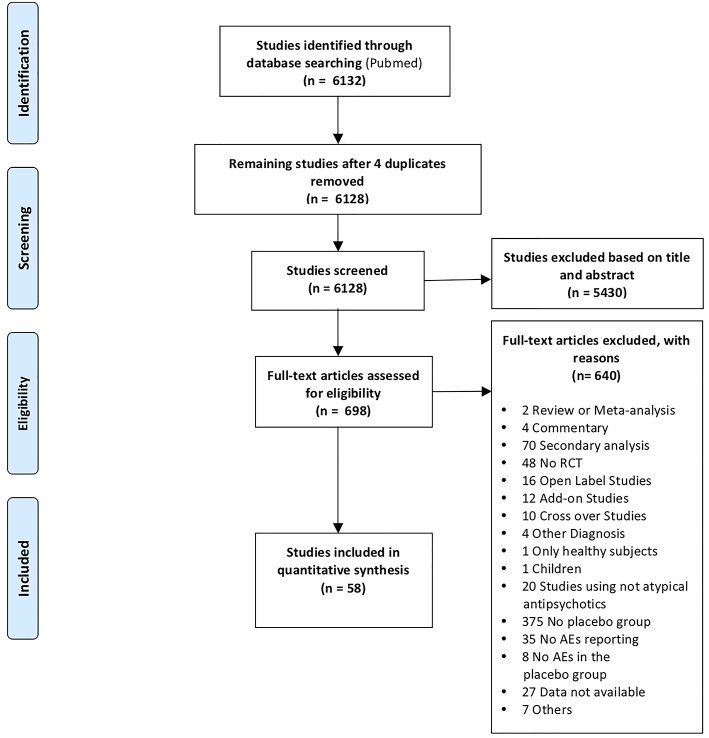
PRISMA flow chart.